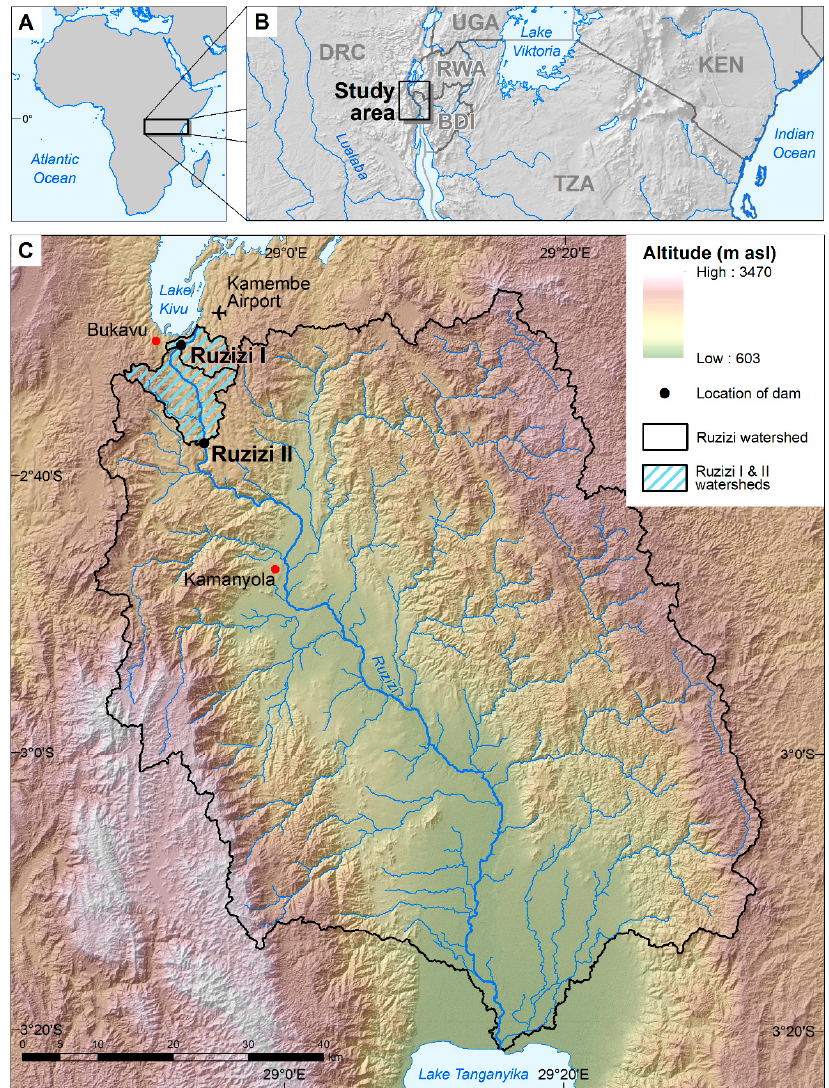
Figure 1. Location of the study area on the African continent ( A ), in Eastern Africa ( B ), and in the Ruzizi catchment area in the Eastern DRC near Bukavu at Lake Kivu ( C ). The northern part of the river represents the border between Rwanda and the DRC. As a result of the Rwandan genocide, war and insecurity in the region increased, accompanied by an escape of rural populations to the larger towns. Bukavu is the capital of South Kivu province with a number of inhabitants estimated at 950,000 in 2013 [43]. The relief forces people to also settle on steep slopes or in alluvial plains. Agriculture is conducted close to their huts. Both settling and conducting agricultural activities in such a relief under a humid climate lead to high erosion and landslides.